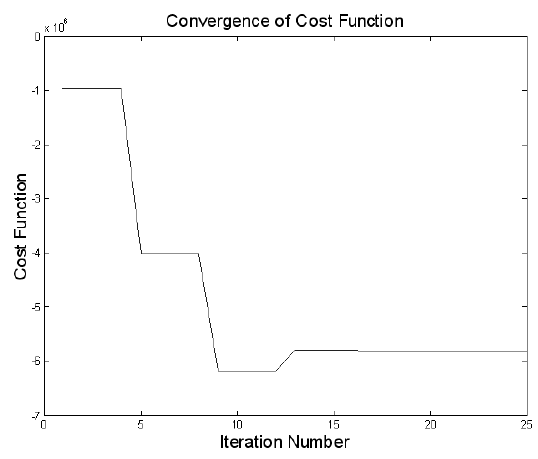
Figure 3. Convergence plot of the optimization